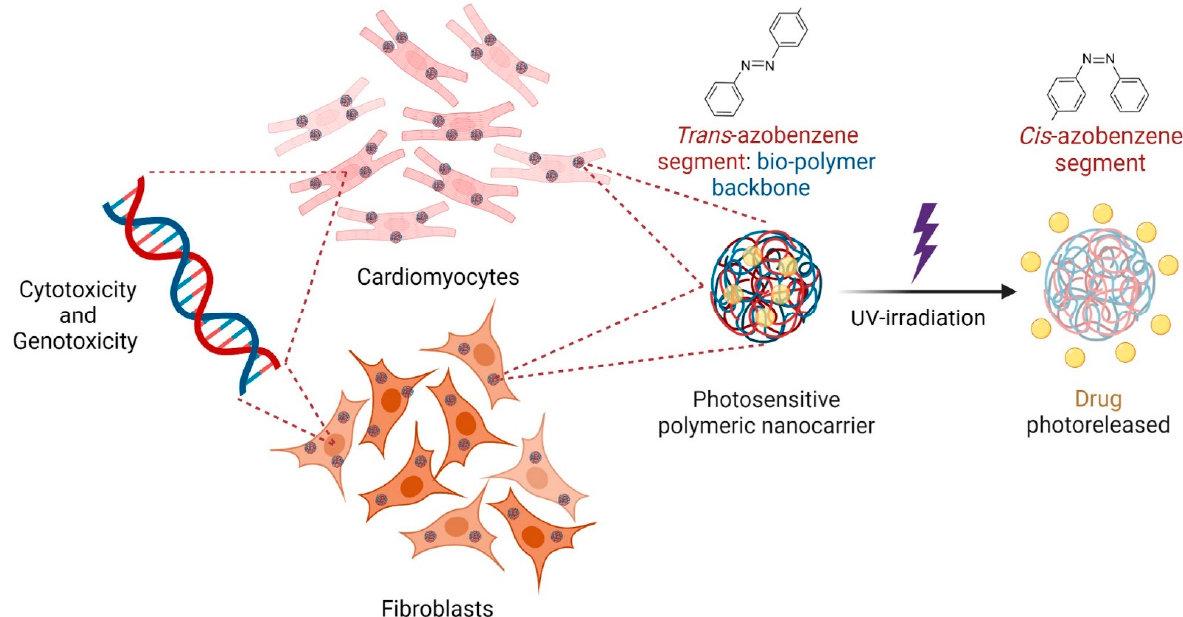
Figure 1. Schematic illustration of cytotoxicity and genotoxicity of azobenzene-based polymeric nanocarriers for phototriggered drug delivery in biomedical applications.